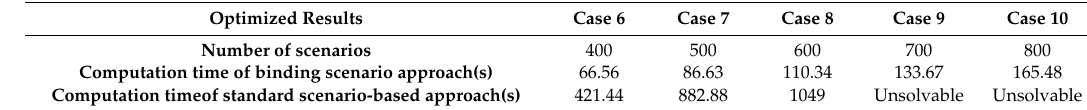
Table A5. Comparison of the computation times of the two algorithms in Cases